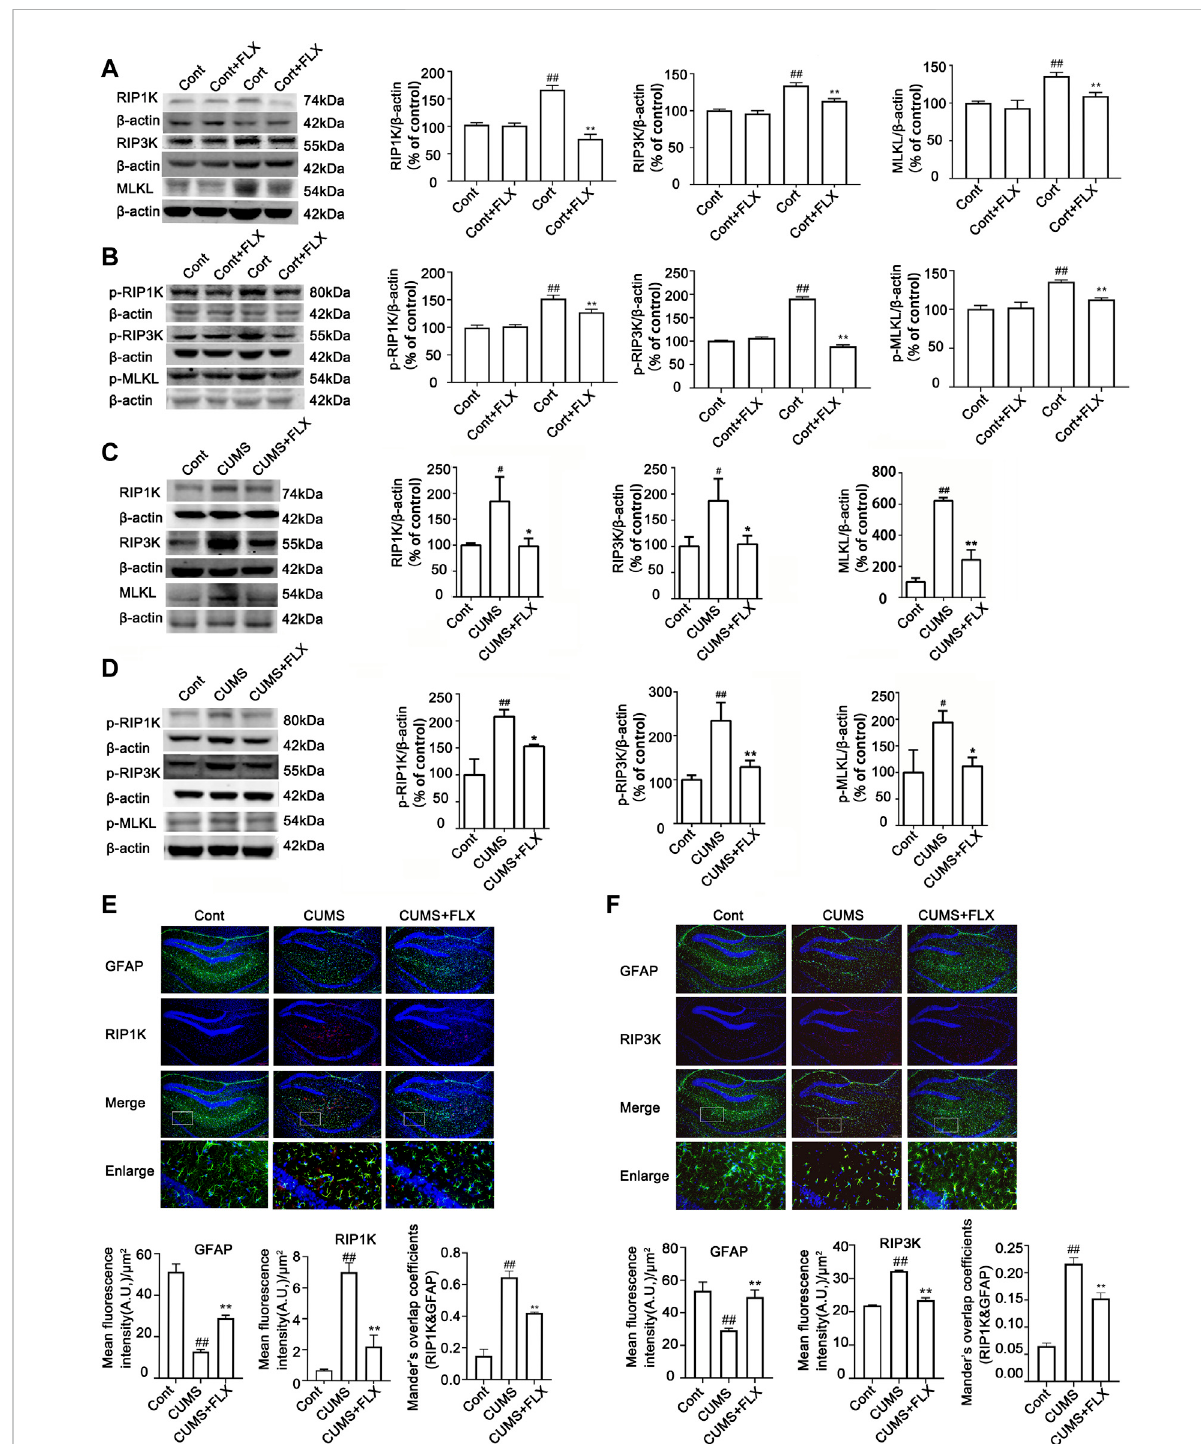
FLXtreatmentinhibitsCUMS-orCort-inducedactivationofnecroptotickinasesofastrocytesinthehippocampusofmiceorinHAcells.HAwas exposed to 200 μ M Cort for 1 h. HA was treated with 1 μ M FLX during Cort treatment. The mice were treated with CUMS for 5 weeks, and FLX (10 mg/kg) was administered intraperitoneally every day during CUMS treatment. (A and B) Representative Western blotting images showing the expression of RIPK1/RIPK3/MLKL and p-RIPK1/p-RIPK3/p-MLKL in Cont- or Cort-treated HA. β -actin was used as a loading control. ImageJ software was used for immunoblotting quanti fi cation, and statistics were performed by one-way ANOVA with Tukey ’ s test . Mean ± SD , n = 3